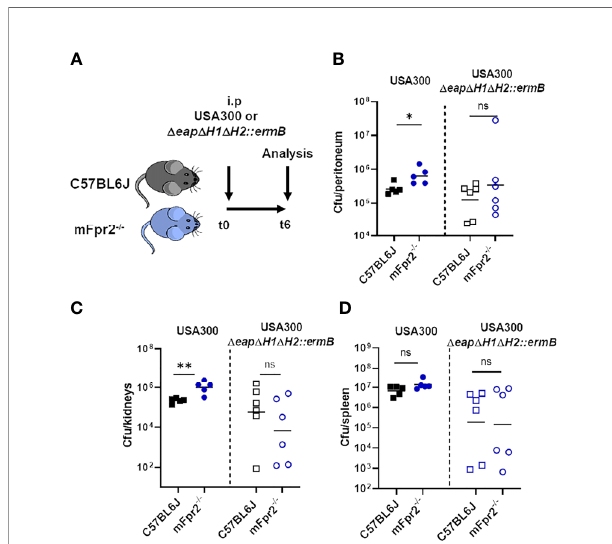
FIGURE 7 | Absence of mFPR2 leads to impaired killing of wild-type USA300, but not of the NSP-inhibitor mutant in vivo. WT and isogenic mFpr2 -/- mice were intra-peritoneal infected either with USA300 or the isogenic NSP inhibitor mutant for six hours (A) mFpr2 -/- mice show enhanced bacterial numbers in the peritoneum (B) and in the kidneys compared to WT mice after i.p. infection with USA300 for six hours, but no difference between WT and mFpr2 -/- mice after infection with the USA300 D eap D H1 D H2::ermB mutant (C) . Infection with the USA300 D eap D H1 D H2::ermB mutant led to less bacterial dissemination into the spleen, but to no difference in bacterial load between WT and isogenic Fpr2 -/- mice (D) . Data in all panels represent geometric means from two independent experiments. Ns, not signi fi cant; * P < 0.05; * *P < 0.01 signi fi cant difference versus the indicated WT mice infected with the USA300 wild-type (left) or with the isogenic USA300 D eap D H1 D H2:: ermB mutant as calculated by Mann-Whitney-U